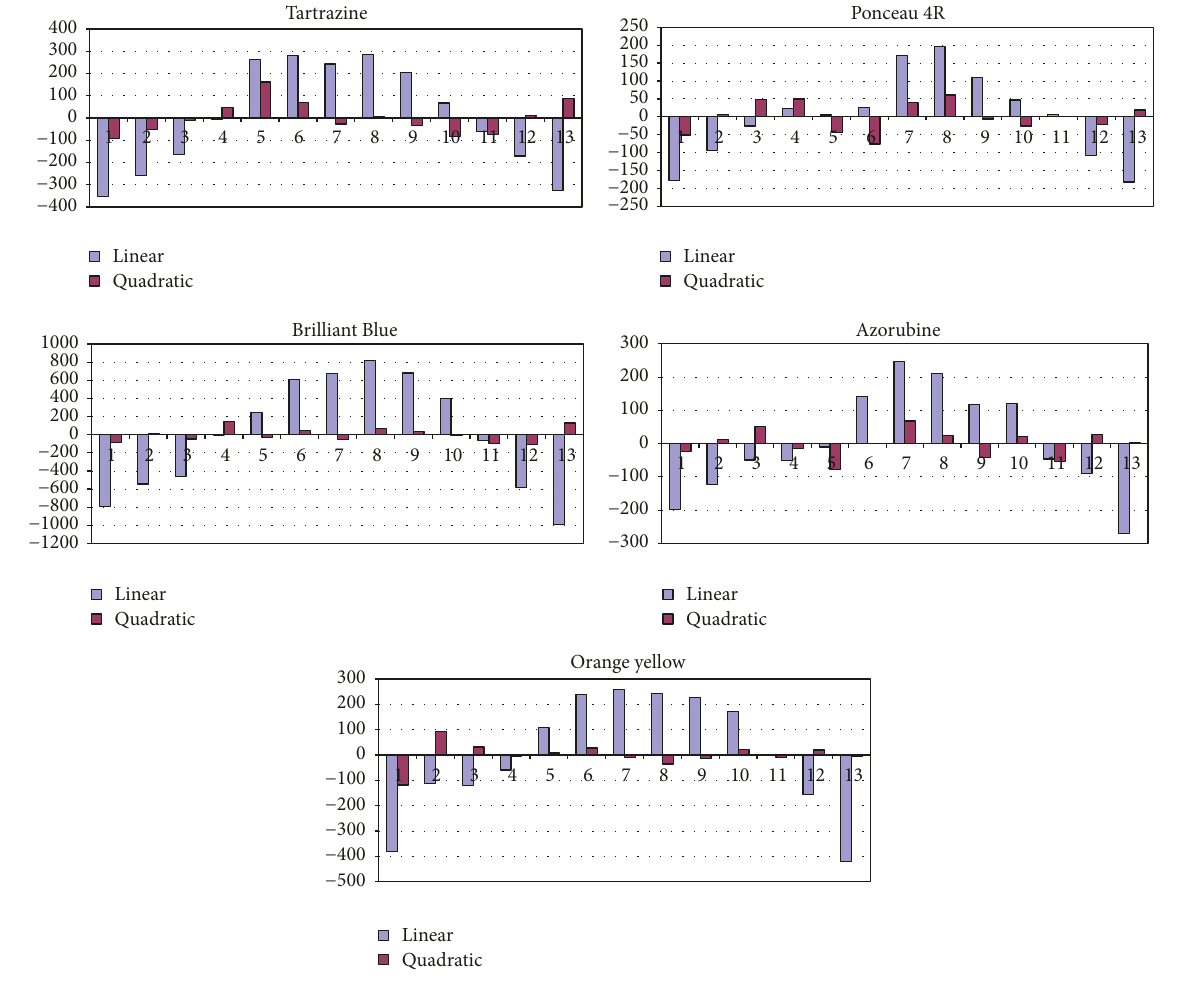
Figure 3: Comparison of residues for linear and quadratic calibration plots.